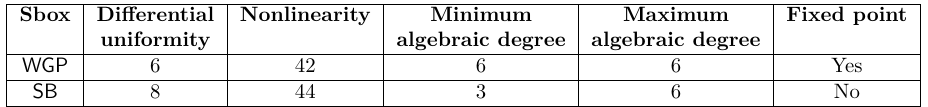
Table 2: Cryptographic properties of WGP and